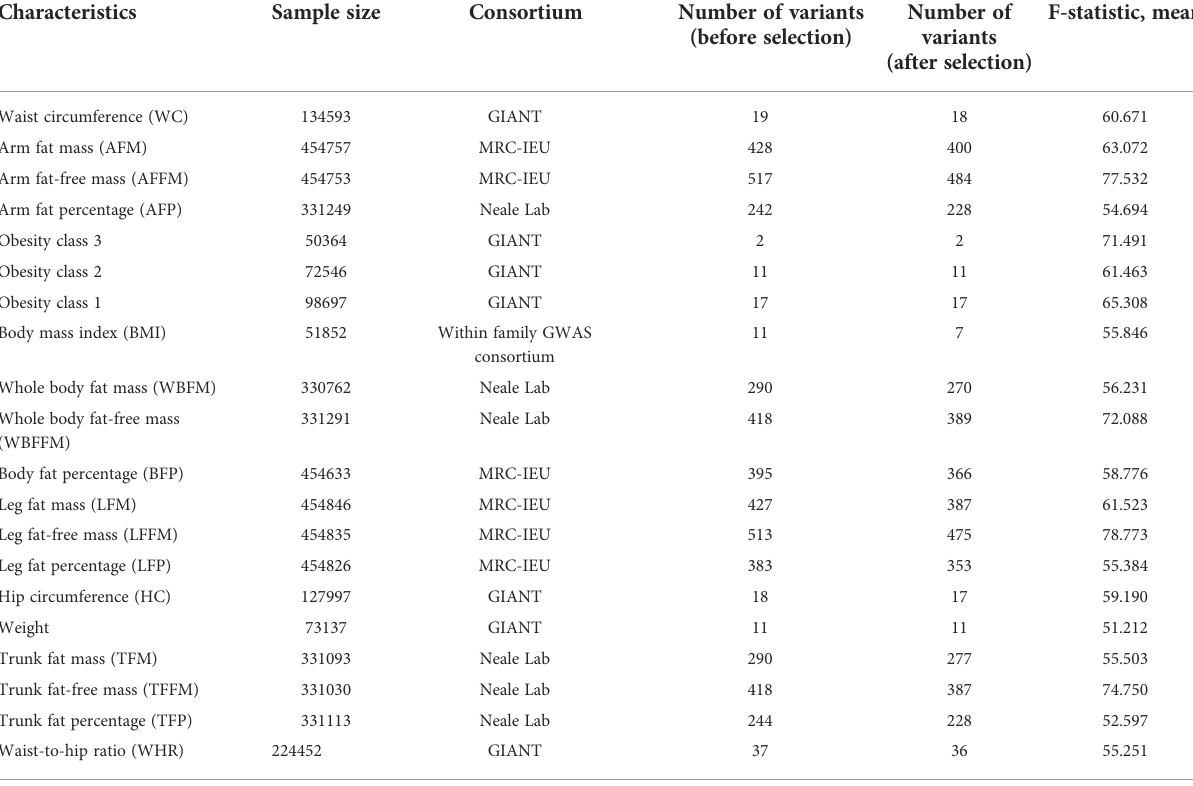
TABLE 1 Overview of genome-wide association studies used in the analyses for the exposures and characteristics of the Single Nucleotide Polymorphisms (SNPs) considered as instrumental variables.